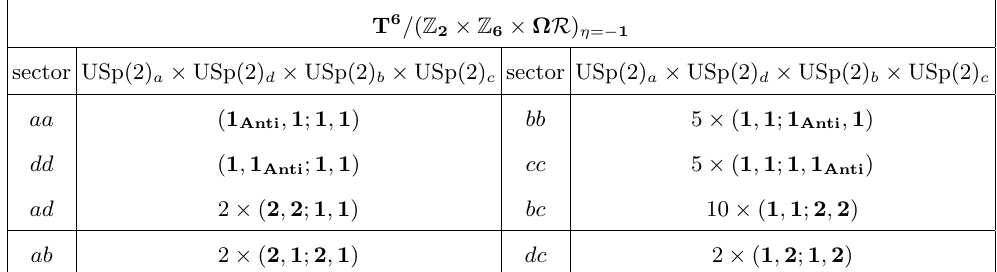
Table 15 . Massless matter spectrum of the global USp(2) 4 model with rigid D6-brane con(cid:12)guration speci(cid:12)ed in table 13 on the aAA lattice of T 6 = ( Z 2 (cid:2) Z 6 (cid:2) (cid:10) R ) with discrete torsion, which is chosen such that the bb , bc and cc sectors agree with those of the L-R symmetric models and the PS I model in table 19. The ac and db sectors do not contain any massless